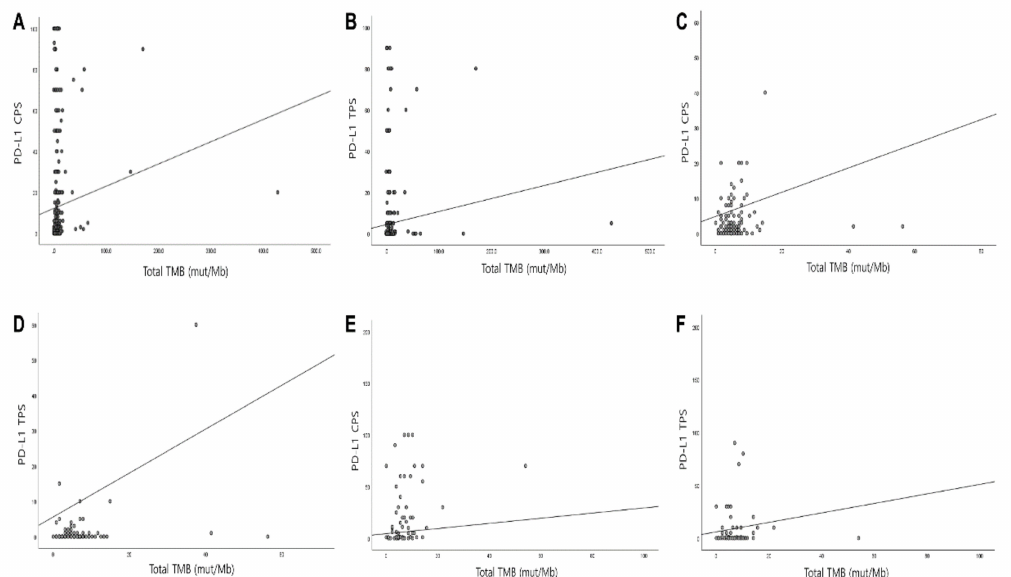
Figure 2. Correlation of the PD-L1 score with the tumor mutation burden (TMB). ( A ) Correlation of TMB and PD-L1 CPS score and in ( B ) TPS scores all samples. Significant correlation of ( C ) TMB and PD-L1 CPS score and ( D ) TMB and PD-L1 TPS score in gastric carcinoma. Significant correlation of ( E ) TMB and PD-L1 CPS score and ( F ) TMB and PD-L1 TPS score in biliary tract tumor. (Abbreviations: TMB, tumor mutation burden; CPS, combined positive score; TPS, tumor proportion score).